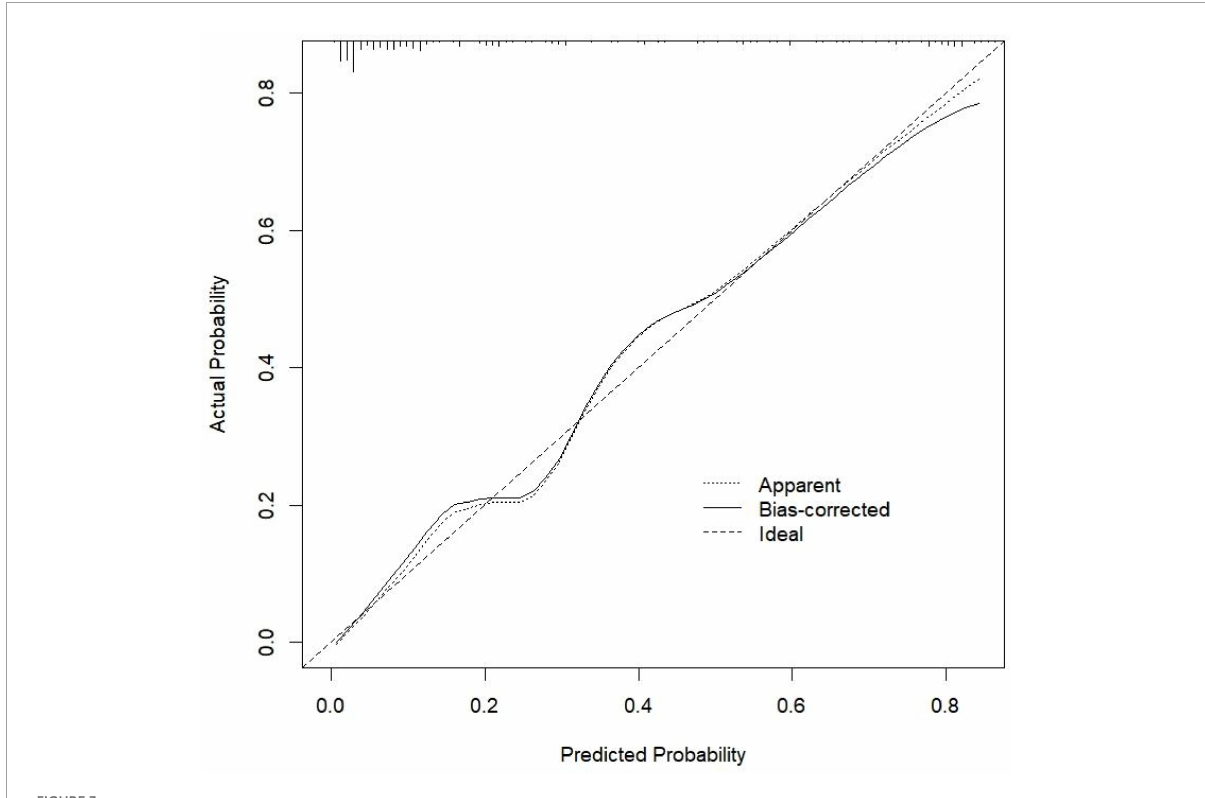
FIGURE3 Calibration curve of the nomogram prediction